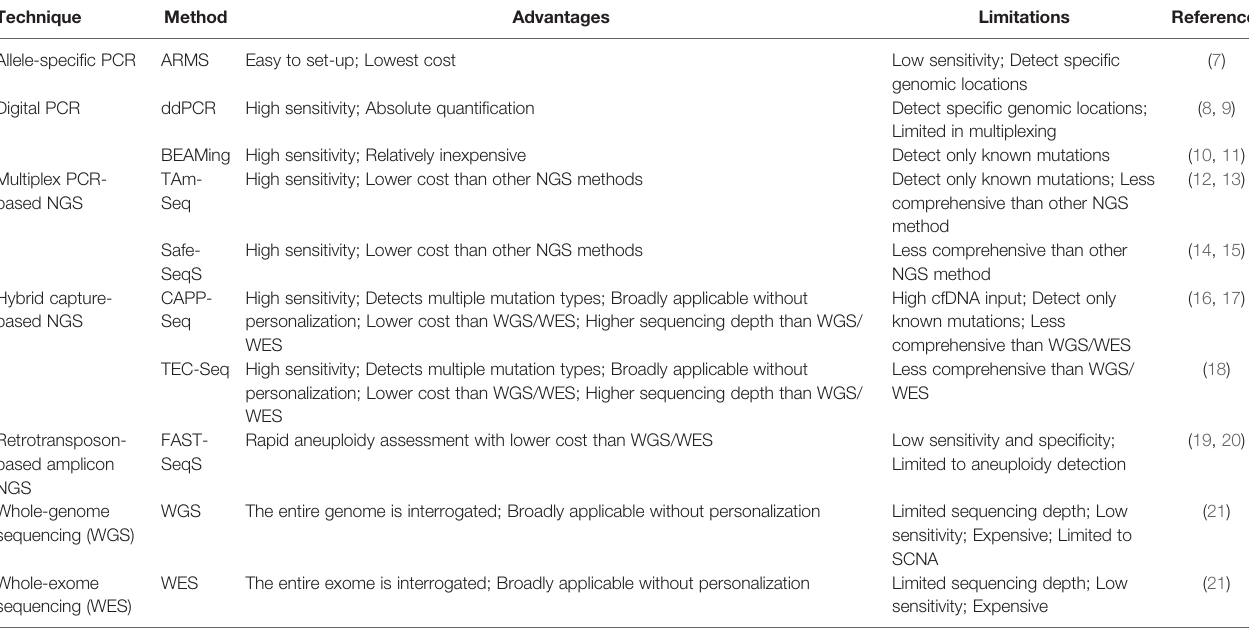
TABLE 1 | Circulating tumor DNA (ctDNA) detection methods.